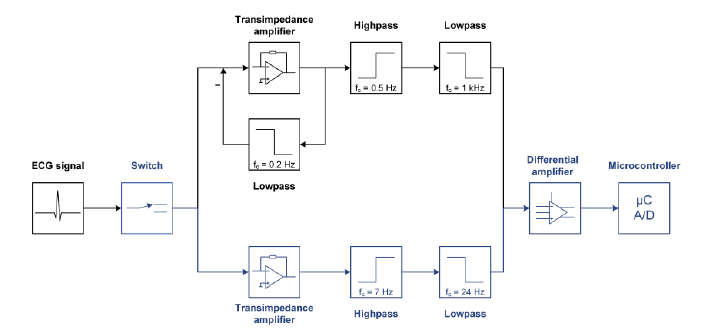
Figure 1. Developed underwater ECG sensor. ( a ) Housing of the sensor. ( b ) Board of the sensor together with the used accumulator.